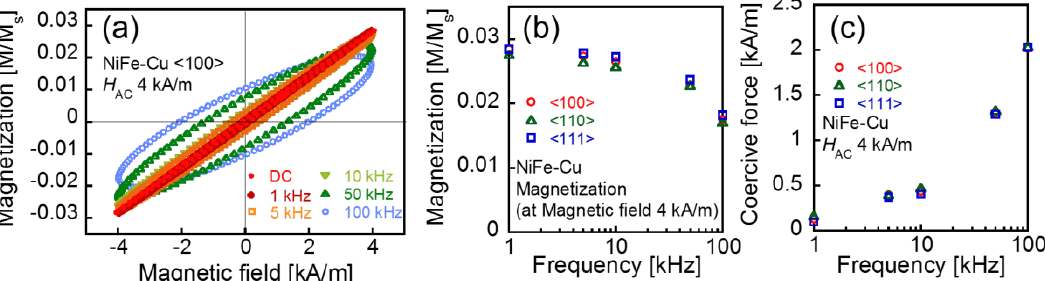
Figure 7. Intrinsic AC magnetization curves of the NiFe-Cu nanocubes for the <100> crystallographic axis ( a ), frequency characteristics of maximum magnetization ( b ), and coercive force ( c ).